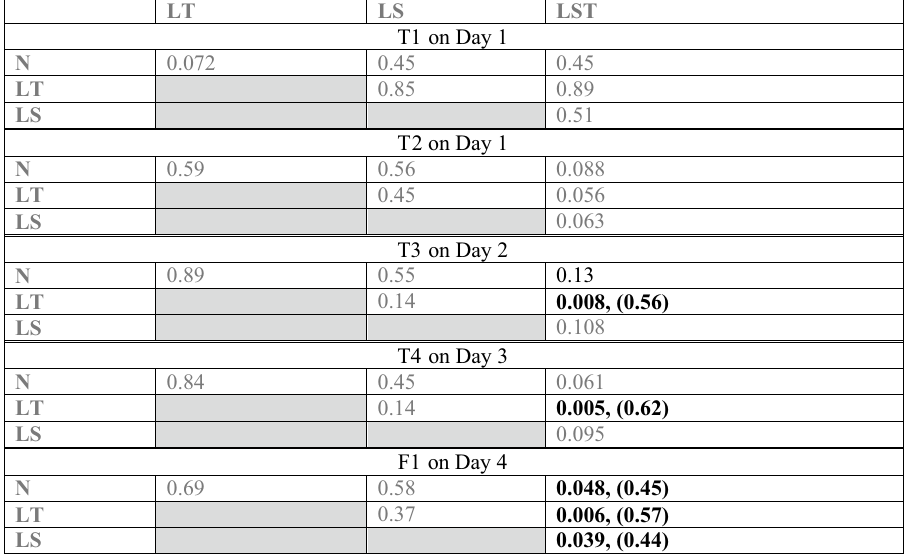
Table 3. Uncorrected post-hoc tests for Intermediate Tests T1, T2, T3, T4 and Final Test F1. The results of the permutation tests are displayed for each test separately (from top to bottom: T1, T2, T3, T4, F1). Non-significant p values are presented in grey, the statistically significant p values and effect sizes (Cohen’s D in parentheses) are displayed in bold